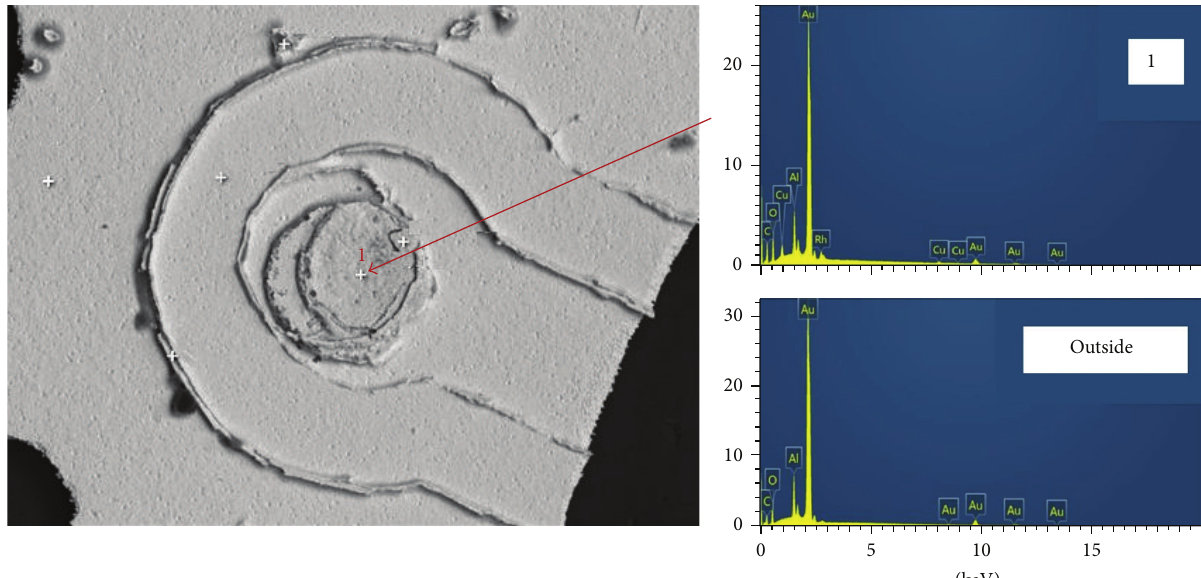
Figure 3: SEM image ( × 1100) and EDX analysis of the movable cover of DS switch and its reverse side. The elemental composition (wt.%) in point (1) on the contacting surface (marked in Figure 1(b) by #4) is Au 82.8, O 7.4, Al 3.8, Cu 3.2, and Rh 2.8, and in the outside-Au 88.7, O 7.0, and Al 4.3.